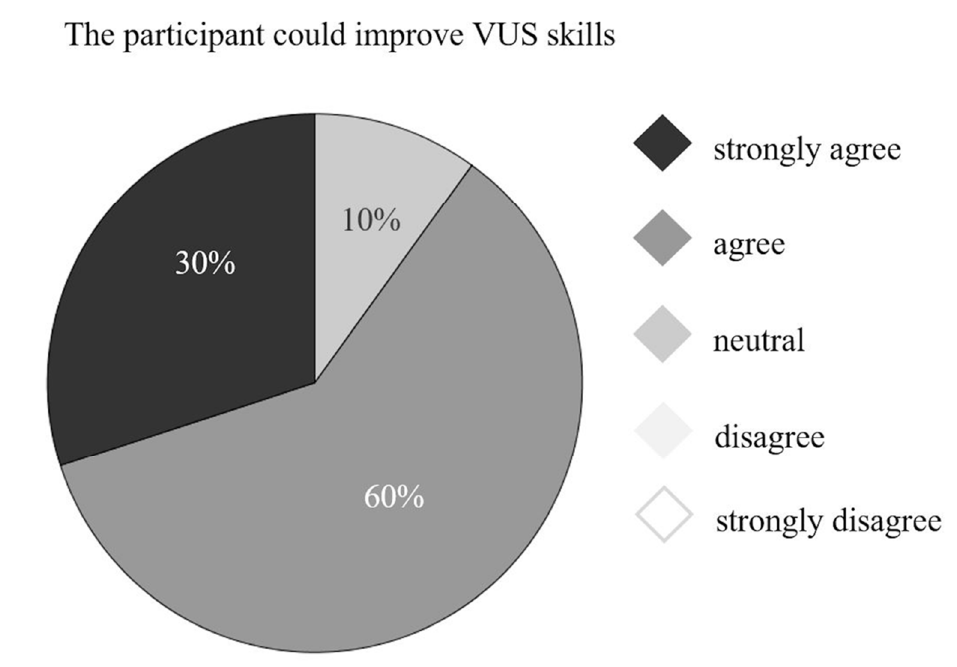
Figure 9. Improvement in VUS skills according to feedback questionnaire.